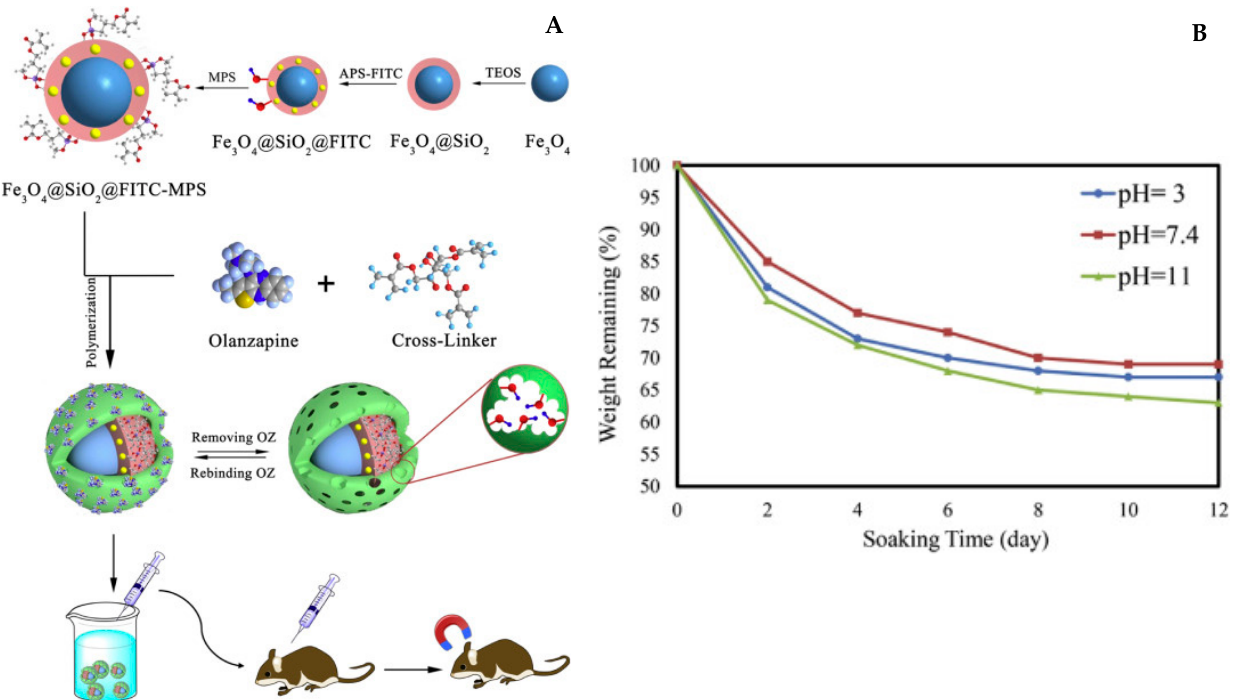
Figure 13. ( A ) An iron oxide core is coated with silica and functionalized with a fructose polymer imprinted with olanzapine, an anti-psychotic drug. ( B) Drug release occurs naturally in the body as the polymer is degraded in a wide range of pHs after a few days. Reproduced with permission from [106] © 2021 Elsevier B.V.